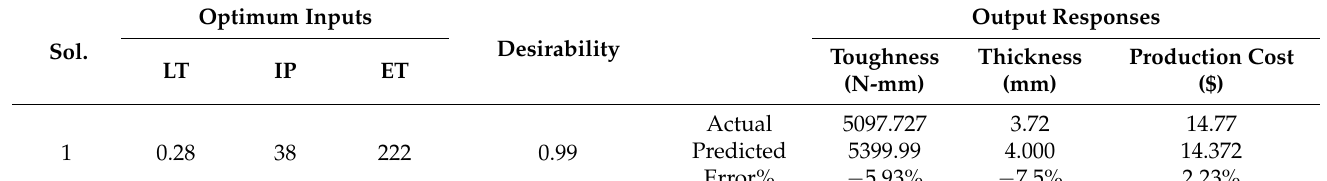
Table 12. Experimental validation and predicted optimum outputs.